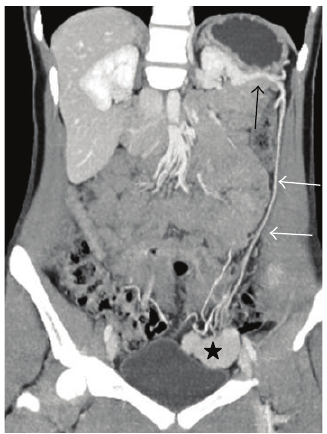
Figure 7: Coronal venous phase MIP image shows a wandering spleen (star) located at pelvis and its vascular pedicle (white arrow) originating from splenic artery (black